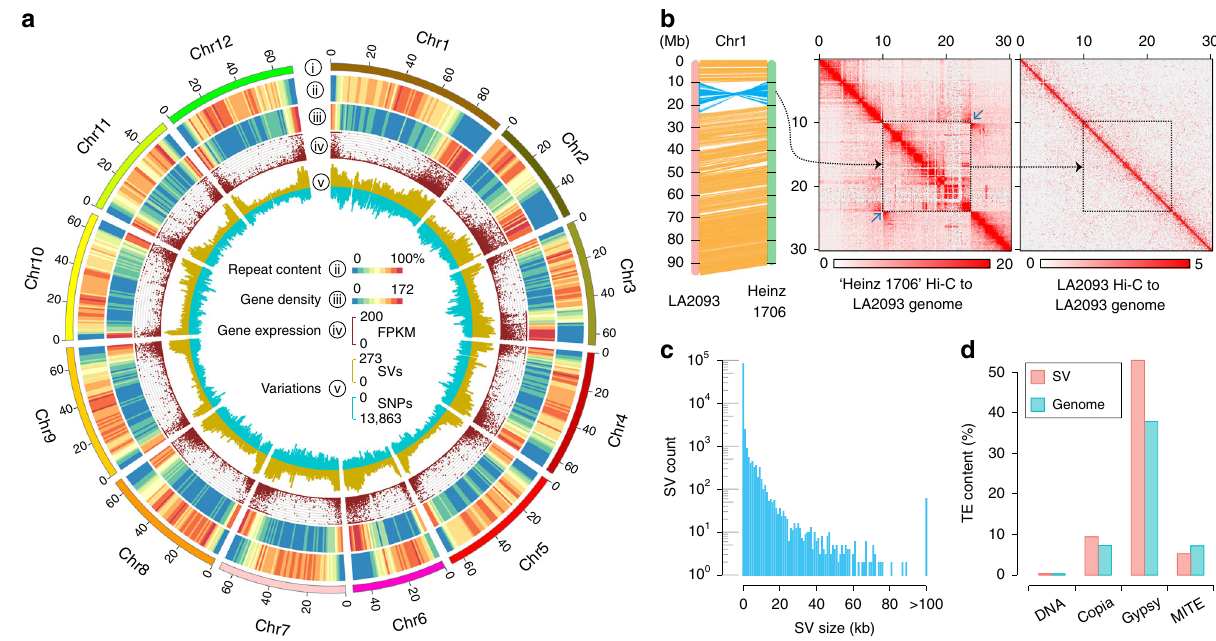
Fig. 1 Genomic landscape of S. pimpinellifolium LA2093 and structural variants identi fi ed between LA2093 and Heinz 1706. a Features of the LA2093 genome. (i) Ideogram of the 12 chromosomes in Mb scale. (ii) Repeat content (% nucleotides per Mb); (iii) gene density (number of genes per Mb). (iv) Gene expression (FPKM). (v) Densities of SVs (structural variants) (outer) and SNPs (inner) in comparison to Heinz 1706 (number of SVs and SNPs per Mb). b Alignment of chromosome 1 between LA2093 and Heinz 1706. The color intensity in Hi-C heatmaps represents the number of links between two 100-kb windows. The inversion shown in blue (left) is supported by high-density contacts pointed by the two blue arrows in Hi-C heatmaps generated from Heinz 1706 Hi-C reads aligned to the LA2093 genome (middle), while no corresponding contract is found in the LA3093 Hi-C heatmap (right). c Distribution of SV sizes. d Contents of different categories of transposable elements in SV regions and the whole-genome of